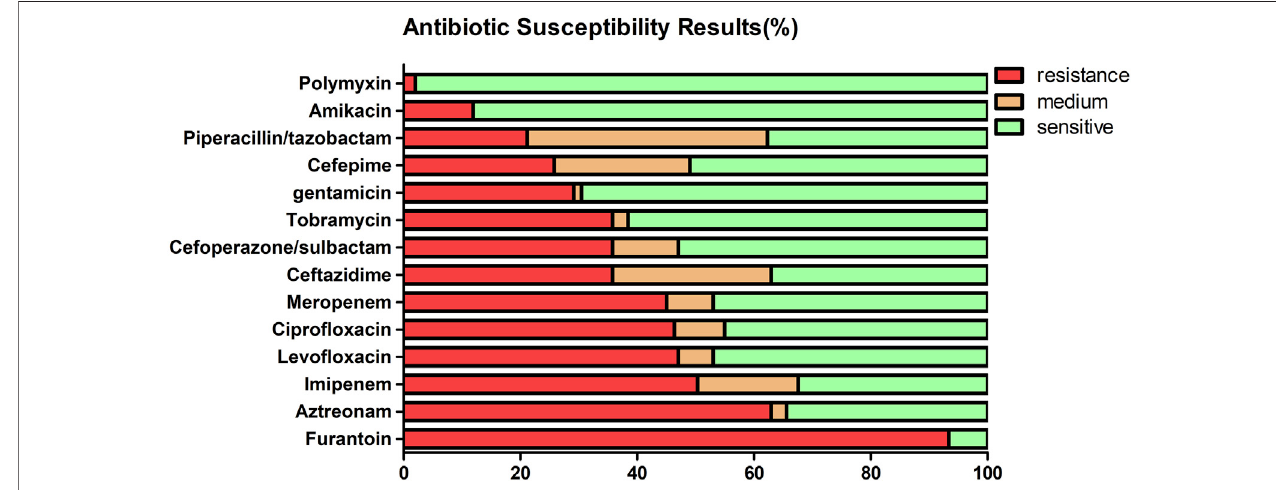
FIGURE 1 | Antimicrobial resistance of the 151 isolates of P. aeruginosa to 14 antibiotics from 2017 to 2021 (%).